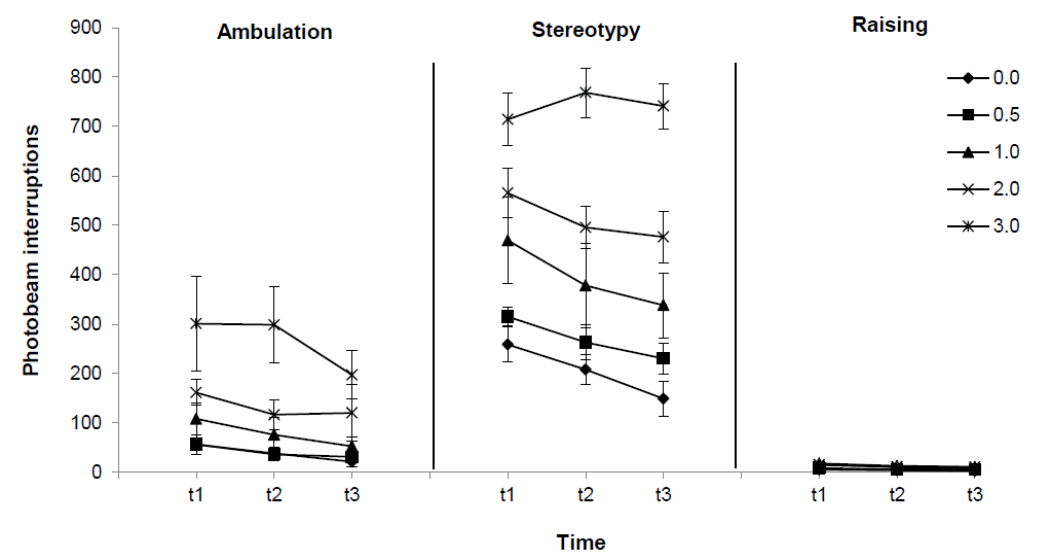
Figure 3. Effect of indatraline ( 1 ) on ambulation, stereotypy and raising episodes. Data represent means (±SE) of photobeam interruptions during 60 (t1), 120 (t2) and 180 (t3) minutes after drug administration of 0.0, 0.5, 1.0, 2.0 and 3.0 mg/kg) for each